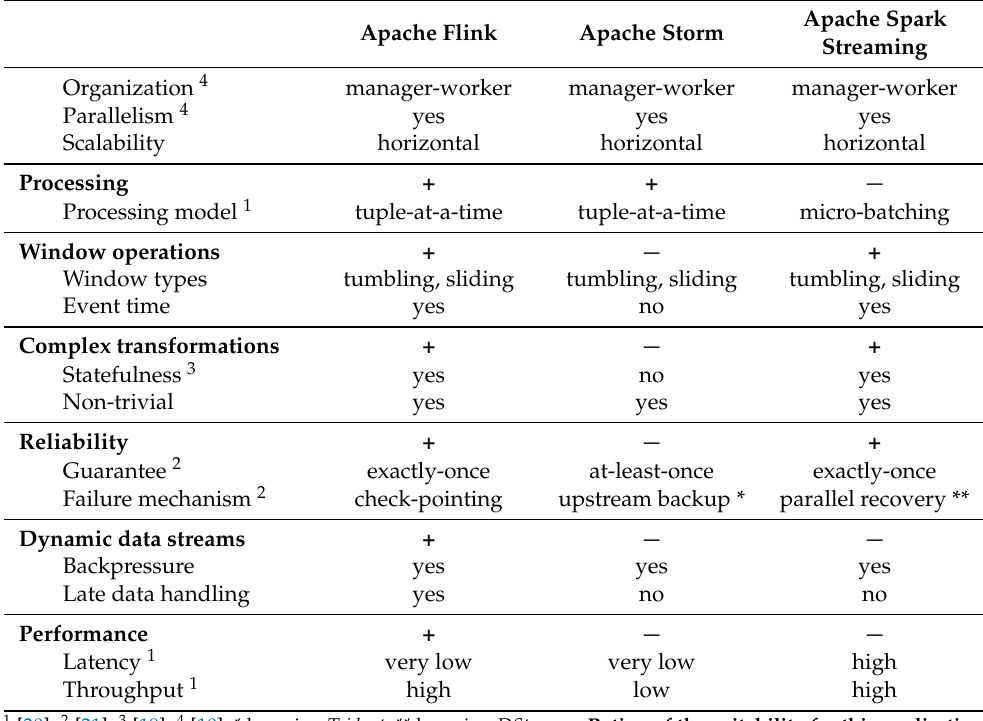
Table 3. Comparison of the considered open-source DSPFs.